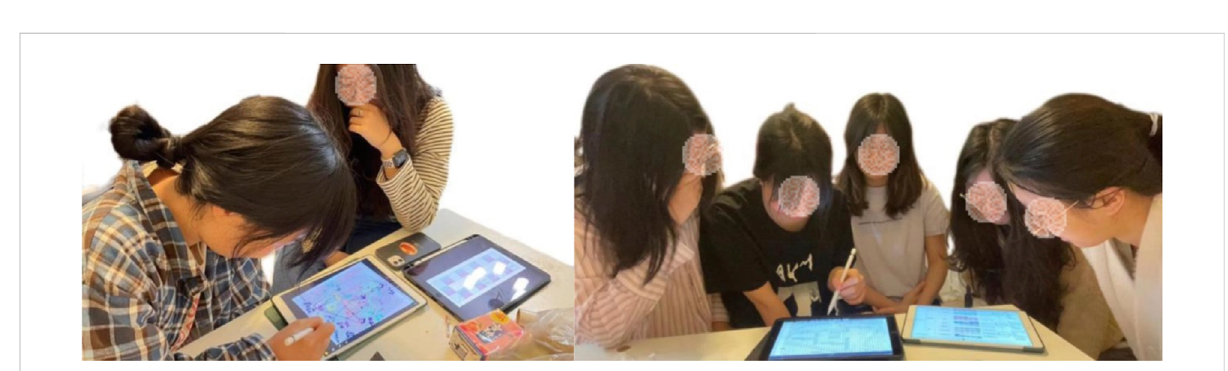
FIGURE 6 Gameplay during Phase 1, using electronic tablets to interact with the game